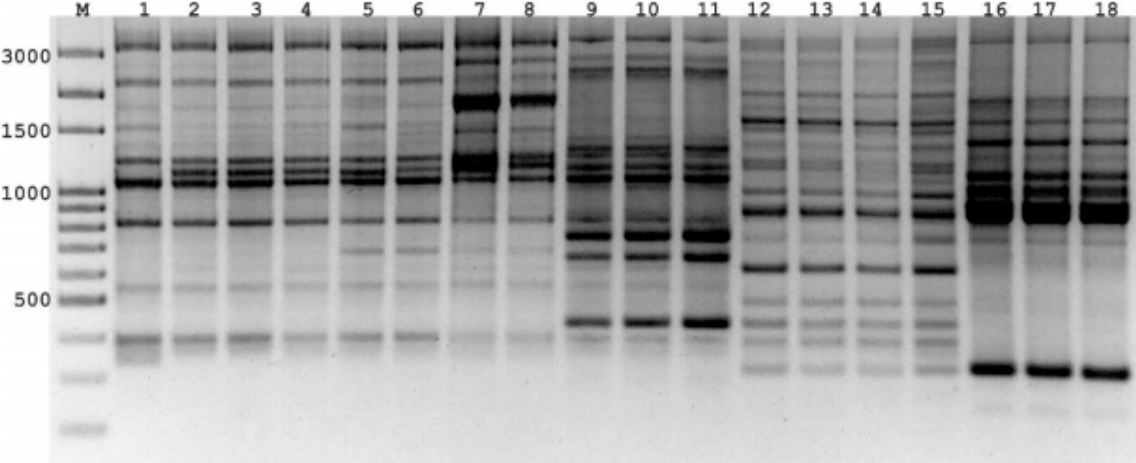
Figure 2. The band profiles with PBS primer (2395) for Rhizoctonia isolates. 1–8-AG4 HG-I; 9–11-AG4 HG-III;